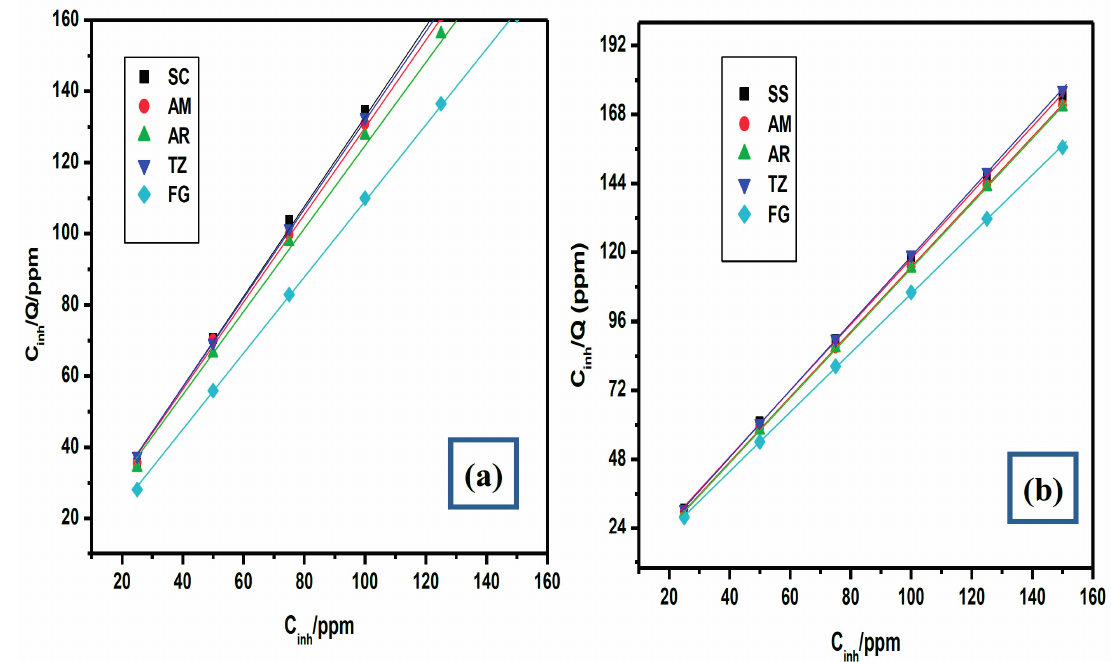
Figure 3. Langmuir adsorption isotherm plots for the adsorption of the studied dyes at 303 K ( a ) without KI and ( b ) with